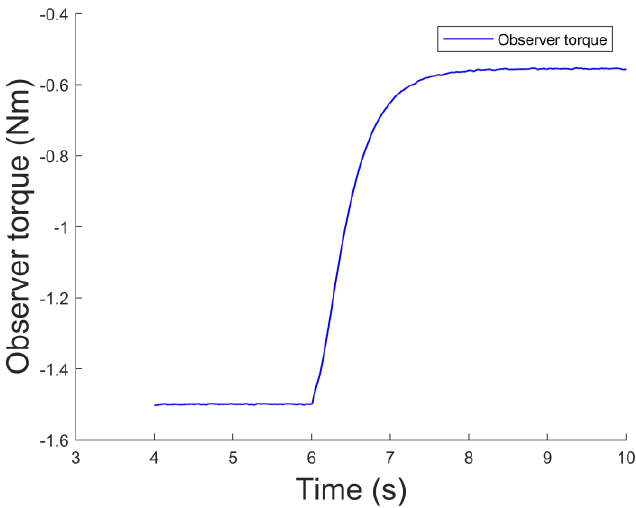
Figure 13. Simulation on robot extended state observer.